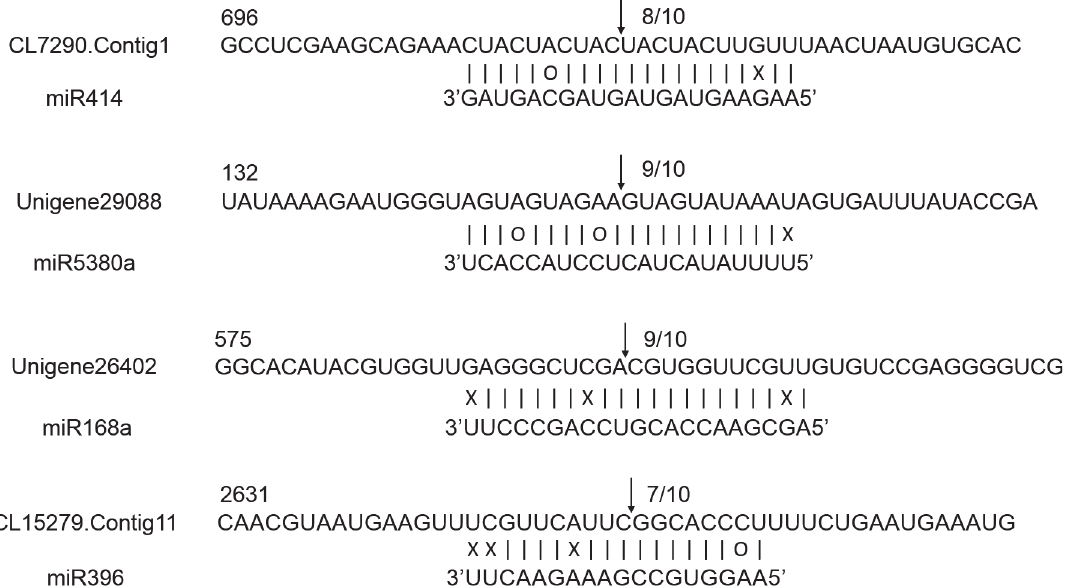
Fig 5. Mapping of mRNA cleavage sites confirmed by 5 ’ RLM-RACE. Arrows indicate the 5 ’ ends of mRNA fragments, as identified by cloned 5 ’ RLM-RACE products, with the frequency of clones shown.